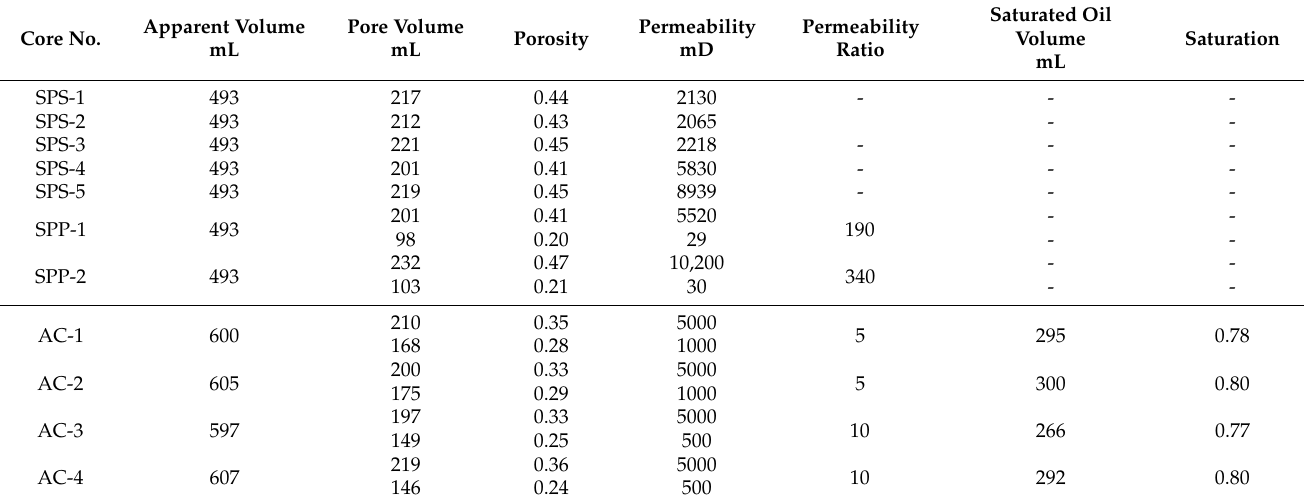
Table 1. Parameters of parallel heterogeneous sand packs and artificial cores.